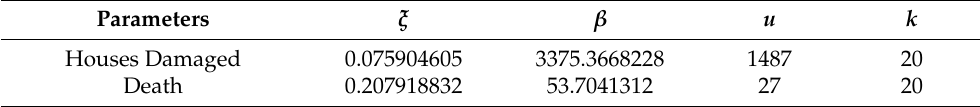
Table 4. Estimated parameter of the generalized Pareto distribution.